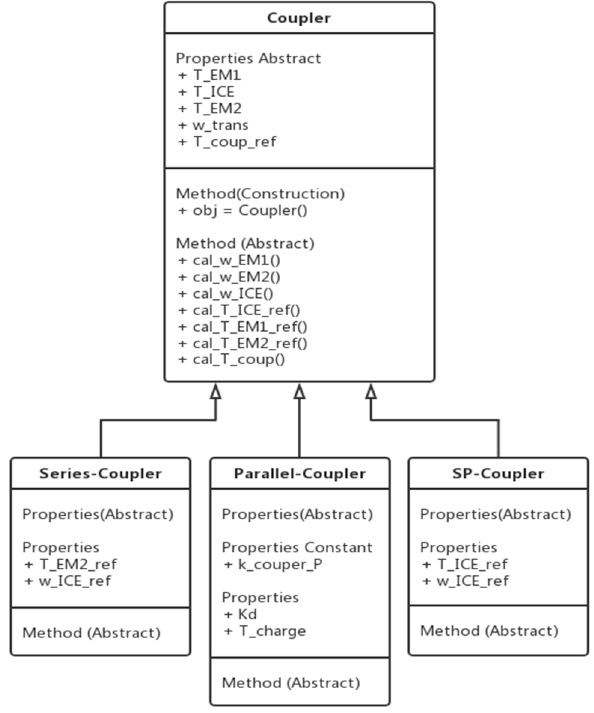
Figure 10. UML of coupler OOP model (power transmission).